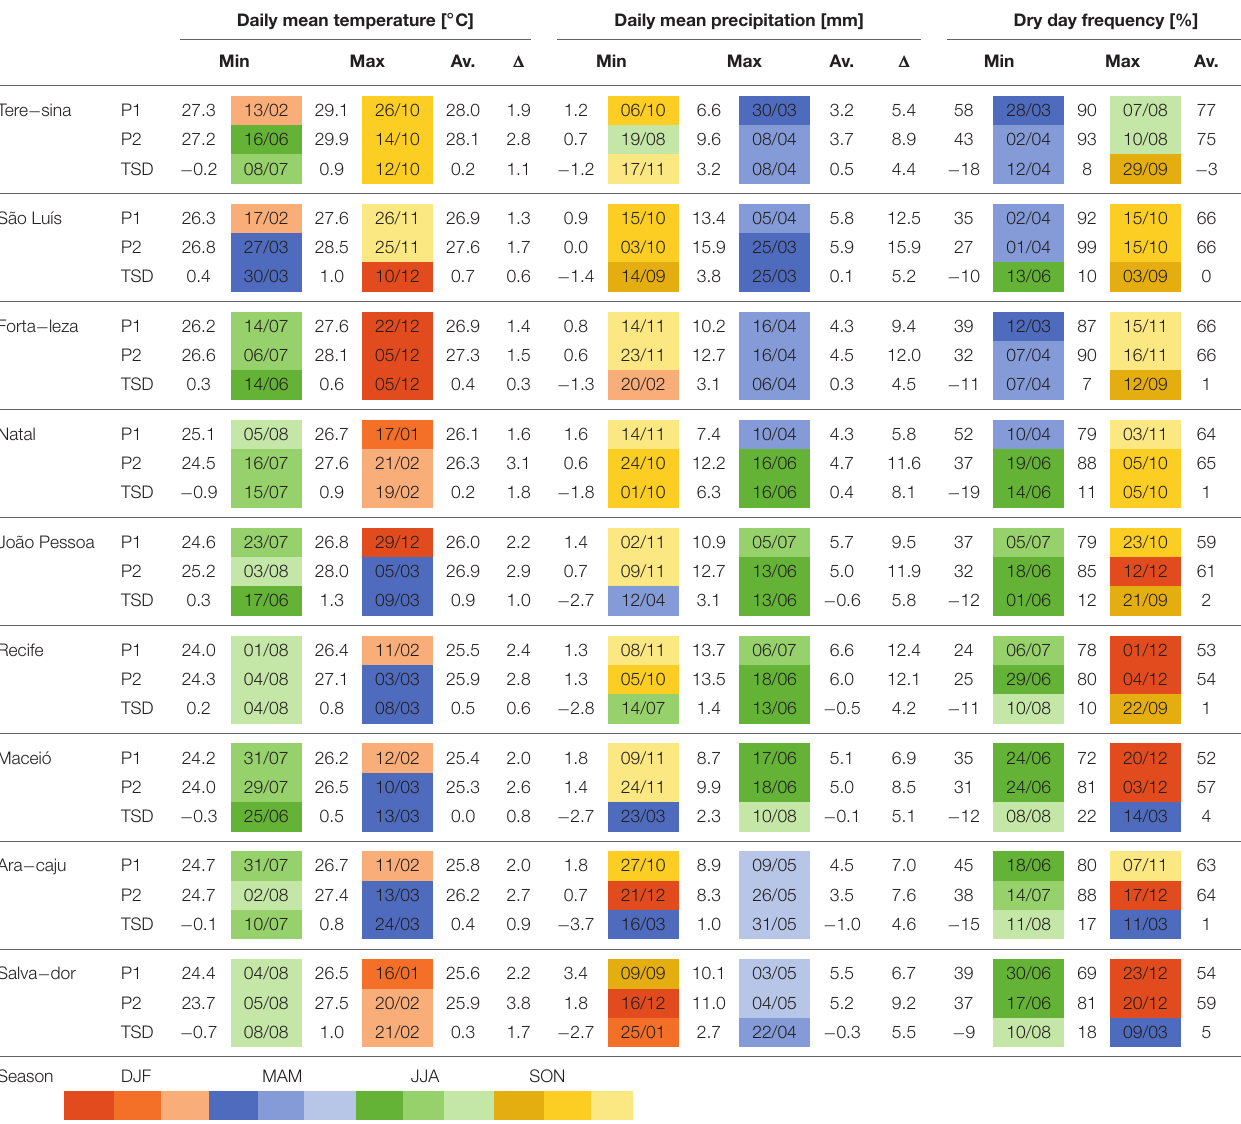
TABLE 3 | Characteristics of the seasonal cycle [Min, lowest value; Max, highest value; Av., Average; 1 , Annual spread (Max minus Min) of the respective variable] of daily mean temperature and precipitation as well as dry day frequency (based on the 31-day centered moving average approach illustrated in Figure 3) within the two periods P1 = 1961–1990 and P2 = 1991–2011 and for the time slice difference (TSD: P2minus